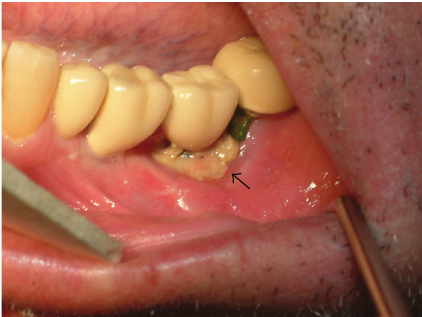
Figure 3: An extensive area of necrotic bone (arrow) is exposed adjacent to the left implant with purulent discharge (September 2008).